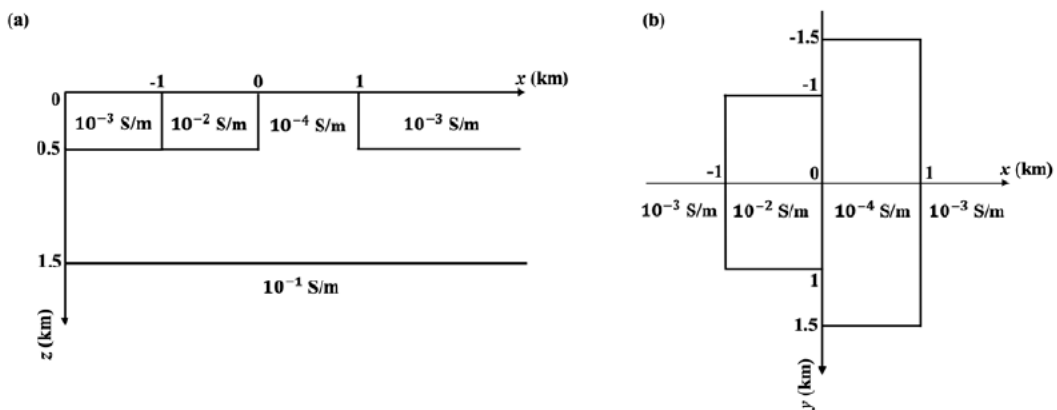
Figure 4. COMMEMI 3D-2 test model: ( a ) x - z section view along y = 0, ( b ) x - y plan view at z = 0.